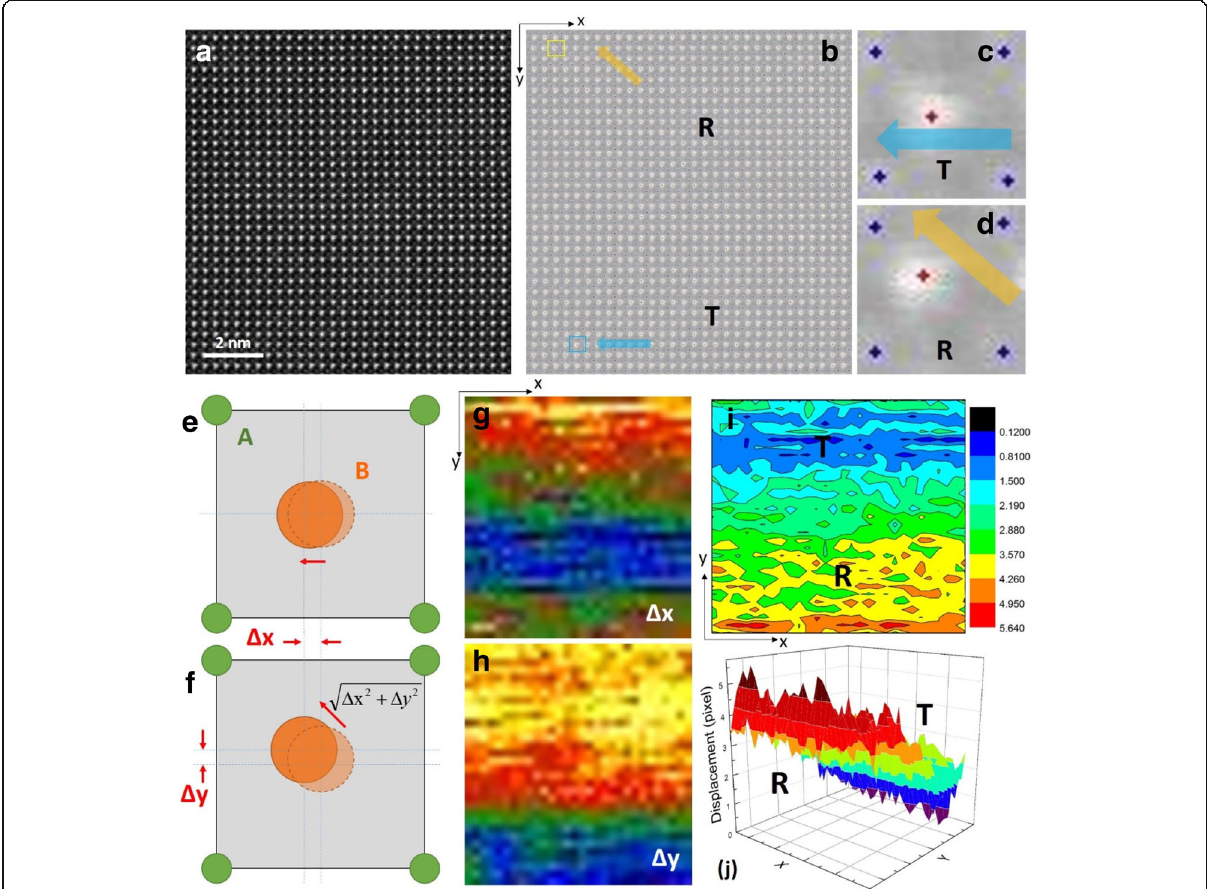
Fig. 4 Local symmetry inside nanodomains of an alkali niobate lead-free ceramic. a STEM HAADF image at a domain boundary; b peak finding on a revealing rhombohedral (R) and tetragonal (T) regions; c enlarged image of the region in a within the blue box, showing T symmetry; d enlarged image of the region in b within the yellow box, showing R symmetry; e , f schematics showing projected atom displacements for T and R symmetry; g , h displacements along x - and y -axes; the region exhibiting displacement along only one axis reflects T symmetry, while the region exhibiting displacement along both x- and y -axes reflects R symmetry. i , j 2D and 3D images showing displacement along the diagonal direction, reflecting different regions with T and R symmetries. Reproduced from Wu et al. 2016. Copyright 2016 American Chemical